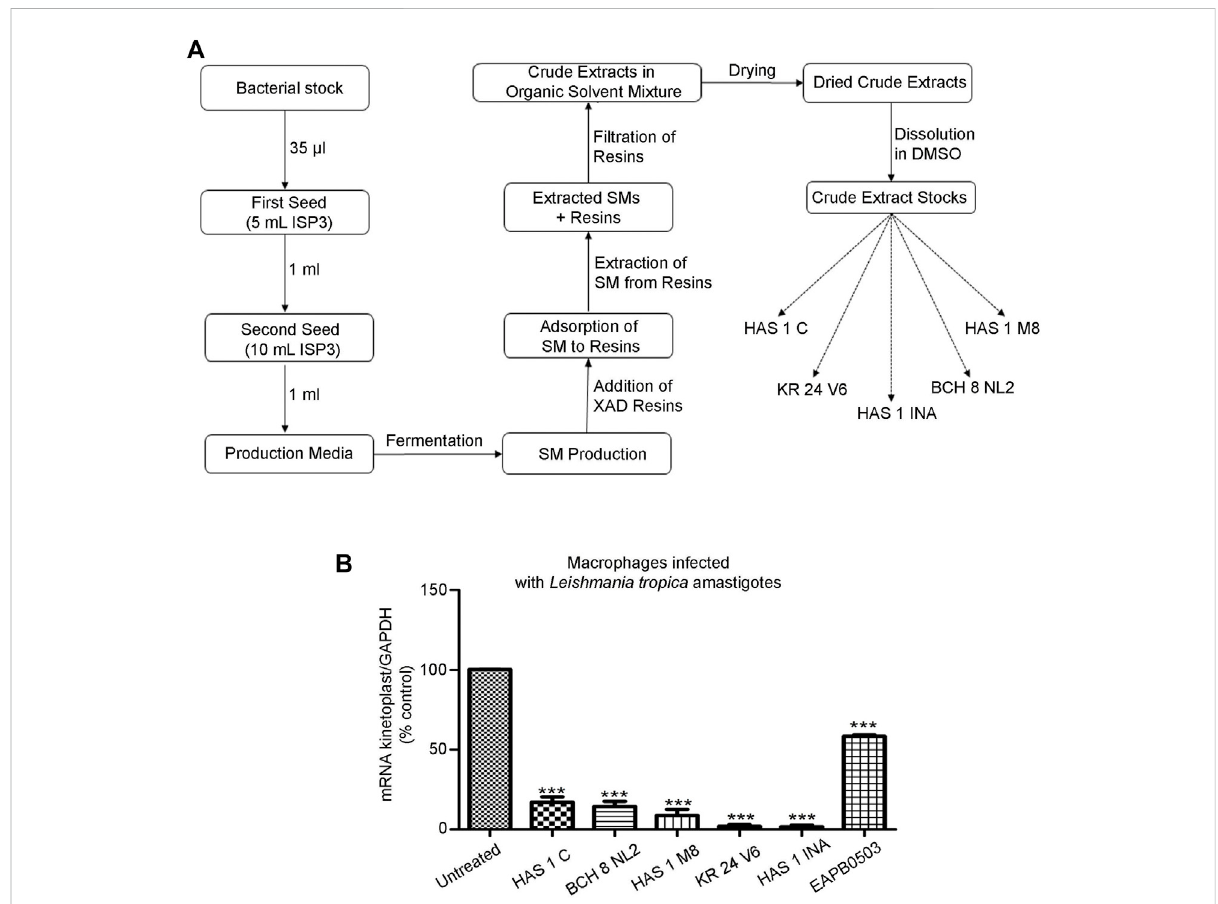
FIGURE 1 Crude extracts produced by environmental bacteria derived from Lebanese soil inhibit L. tropica amastigotes replication. (A) . Pipeline of secondary metabolite production by environmental bacteria isolated from soils collected from selected region across Lebanon. Bacteria from Hasbaya (HAS), Koura (KR) and Bchamoun (BCH) were fermented in a collection of 14 different production media. XAD resins were added 14 days post bacterial inoculation to adsorb the SMs, which were then extracted via organic solvents. The overall SMs collected from an isolate in a speci fi c medium were named after the isolate followed by the medium name, for example HAS1 INA. (B) . Real-time quantitative PCR detection of THP-1 derived macrophages infected with patient-derived L. tropica amastigotes treated with 0.01 μ g/ml of crude extracts HAS1 C, BCH8 NL2, HAS1 M8, KR24 V6, and HAS1 INA for 24 h. Brie fl y, THP-1 monocytes were differentiated into macrophages, activated with LPS, and infected with L. tropica with a ratio of one parasite/three cells. Treatment with 0.01 μ g/ml of the crude extracts or 1 μ M of EABP0503 was then performed for 24 h. The results are shown as percentage of untreated infected macrophages. Amastigote transcripts were evaluated by Syber green RT-PCR using kinetoplast speci fi c primers and their percentage of expression was normalized to GAPDH. Results are expressed as percentage of the untreated control (±) SEM and are representative of at least three independent experiments. To validate statistical signi fi cance, t-tests were used with *** representing p -values <